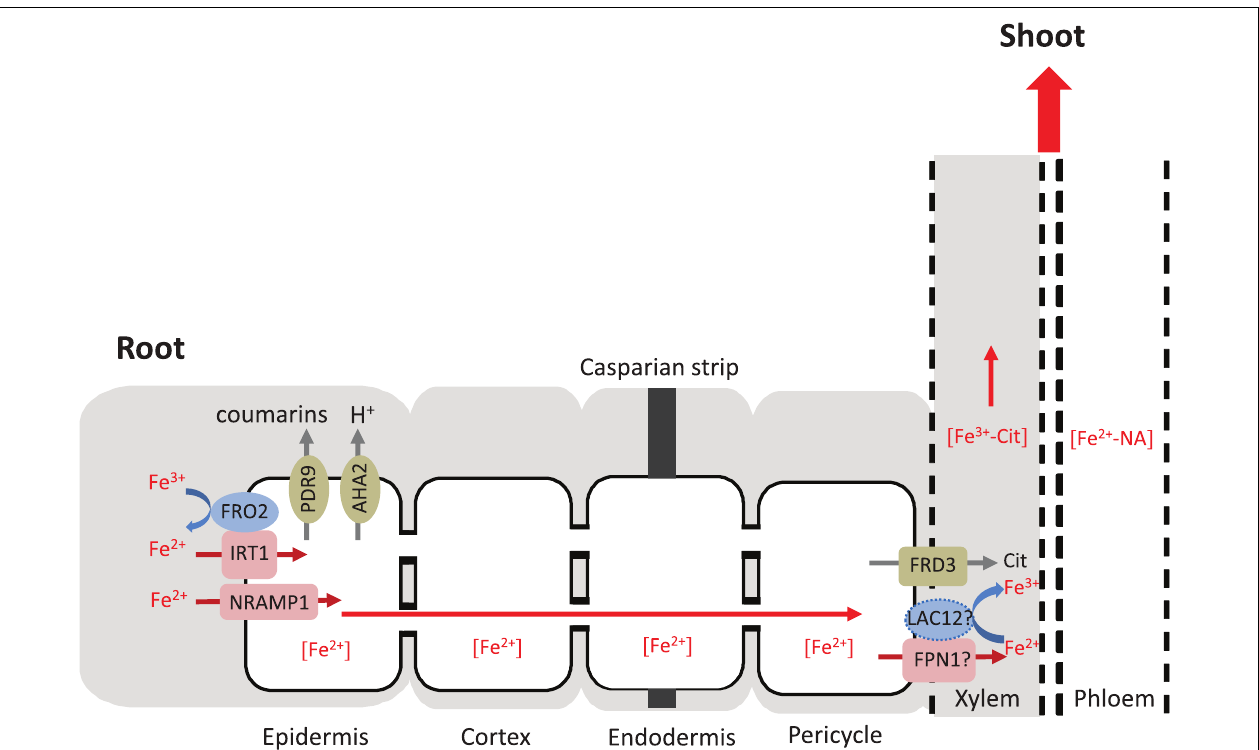
FIGURE 8 | Hypothesis of the role of LAC12 in root Fe homeostasis. The Fe uptake machinery in the root epidermis includes four membrane proteins: PDR9 to exude Fe(III)-binding coumarins, AHA2 to acidify the rhizosphere, FRO2 to reduce Fe(III) to Fe(II) and IRT1 to transport Fe(II) across the plasma membrane into the cytosol (Connorton et al., 2017; Kroh and Pilon, 2020). NRAMP1 contributes to Fe(II) transport as a low-affinity uptake system (Cailliatte et al., 2010). Free or chelated extracellular Fe disseminates or precipitates within the apoplast, and is arrested by the casparian strip that prevents its entry into the stele. Once Fe(II) enters the symplastic pathway of the root epidermal cells, it is probably chelated to a low-molecular-mass ligand molecule, potentially nicotianamine (NA), and can move from cell to cell through plasmodesmata. IRON-REGULATED PROTEIN 1 (also known as ferroportin FPN1) may export Fe(II) from the cytosol of xylem parenchyma cells (not shown) into the xylem vessels (Morrissey et al., 2009). FERRIC REDUCTASE DEFECTIVE 3 (FRD3) drives the efflux of citrate into the xylem, which is critical for root-to-shoot Fe partitioning in the xylem and the leaf apoplast (Green and Rogers, 2004). The primary specie contained in the xylem is an Fe(III)-citrate complex, and consequently it appears that Fe(II) must be oxidized to Fe(III) (Roschzttardtz et al., 2011). According to our hypothesis, LAC12 may be the protein carrying out this function prior to Fe(III) chelation by citrate. Subsequently, the Fe(III)-citrate complex moves upward in the xylem with mass flow. In order to reach sink organs, Fe must be taken up, moved across cells and loaded into the phloem, where it can move as an Fe(II)-NA chelate. According to FACS-transcriptomics results shown in Supplementary Figure 3 , LAC12 probably locates in the procambium and not in the pericycle. The dashed line shows the hypothetical localization of LAC12. The apoplast is marked in gray, the symplast in